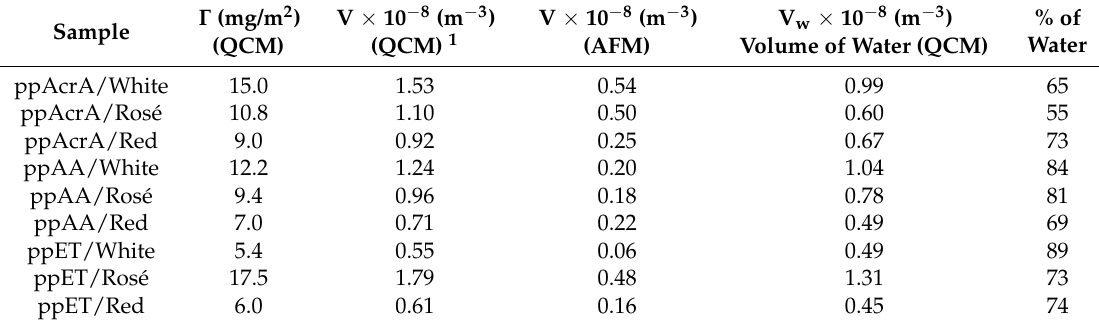
Table 1. Adsorbed amount (G), adsorbed volume (V), volume of water in the adsorbed layer (Vw), and proportion of hydration water for white, rosé, and two red wines onto the three plasma polymer